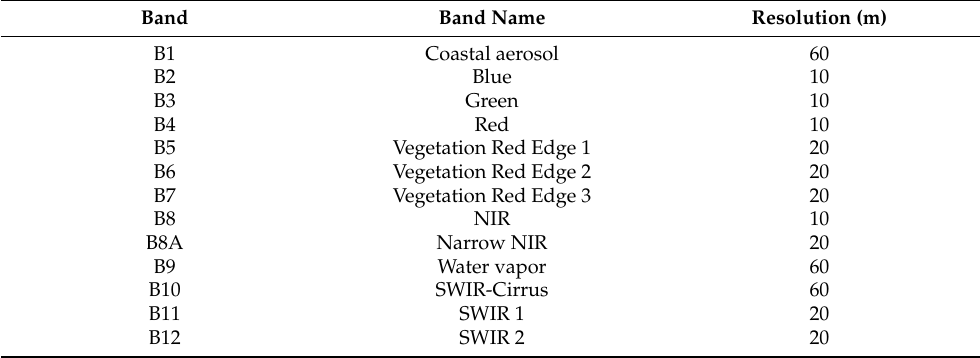
Table 1. The features of Sentinel-2